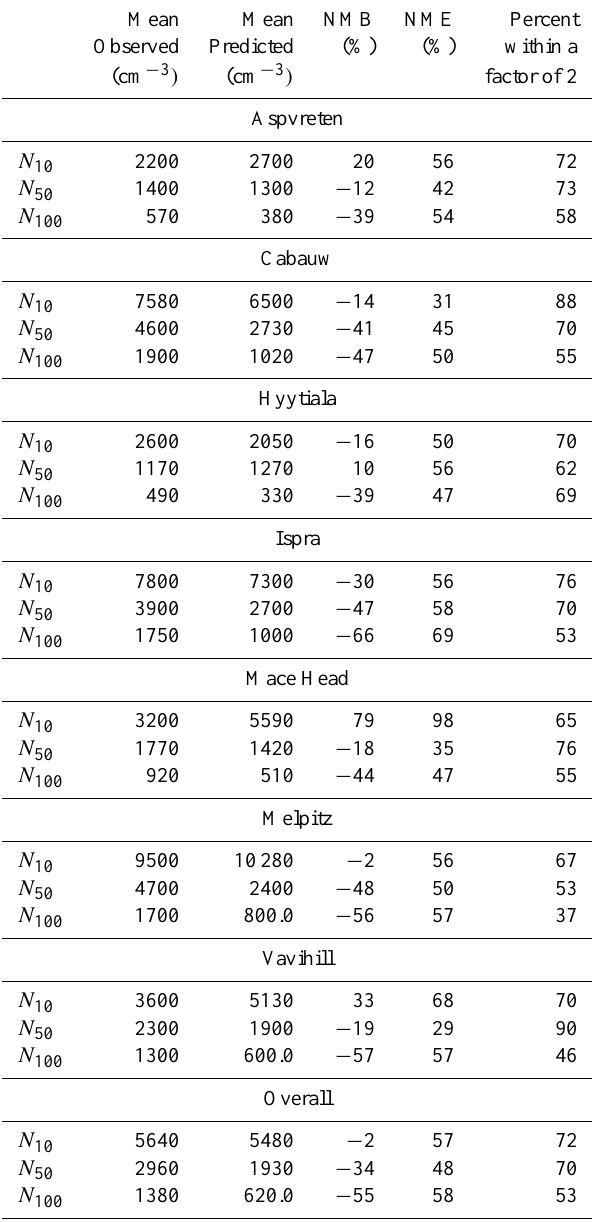
Table 2. Prediction skill metrics of PMCAMx-UF against hourly ground measurements of particle number concentration from 7 sta- tions during May